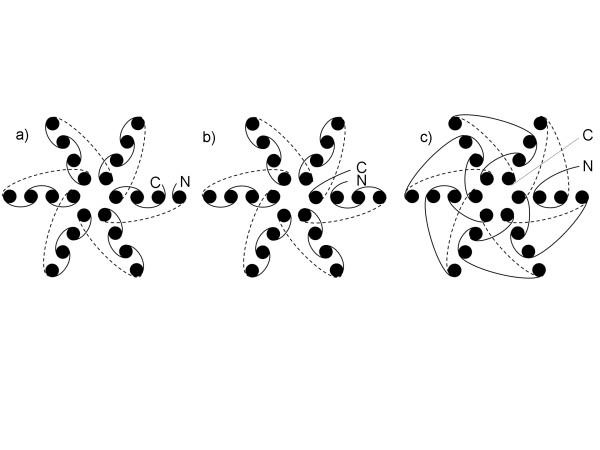
Different topologies of β-strands in the fold of 6-bladed β-propeller. Even though the structures of beta-propeller are symmetrical, none of the proteins with the displayed topologies of β-strands can be aligned in a sequential way. Picture is adopted from Figure 1 in [44].